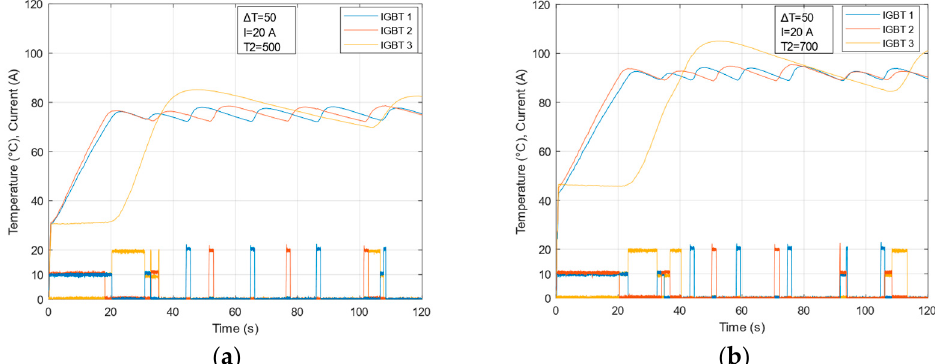
Figure 13. Upper threshold temperature T 2 influence for two main and one redundant IGBTs for ( a ) T 2 = 74 °C; ( b ) T 2 = 90 °C.